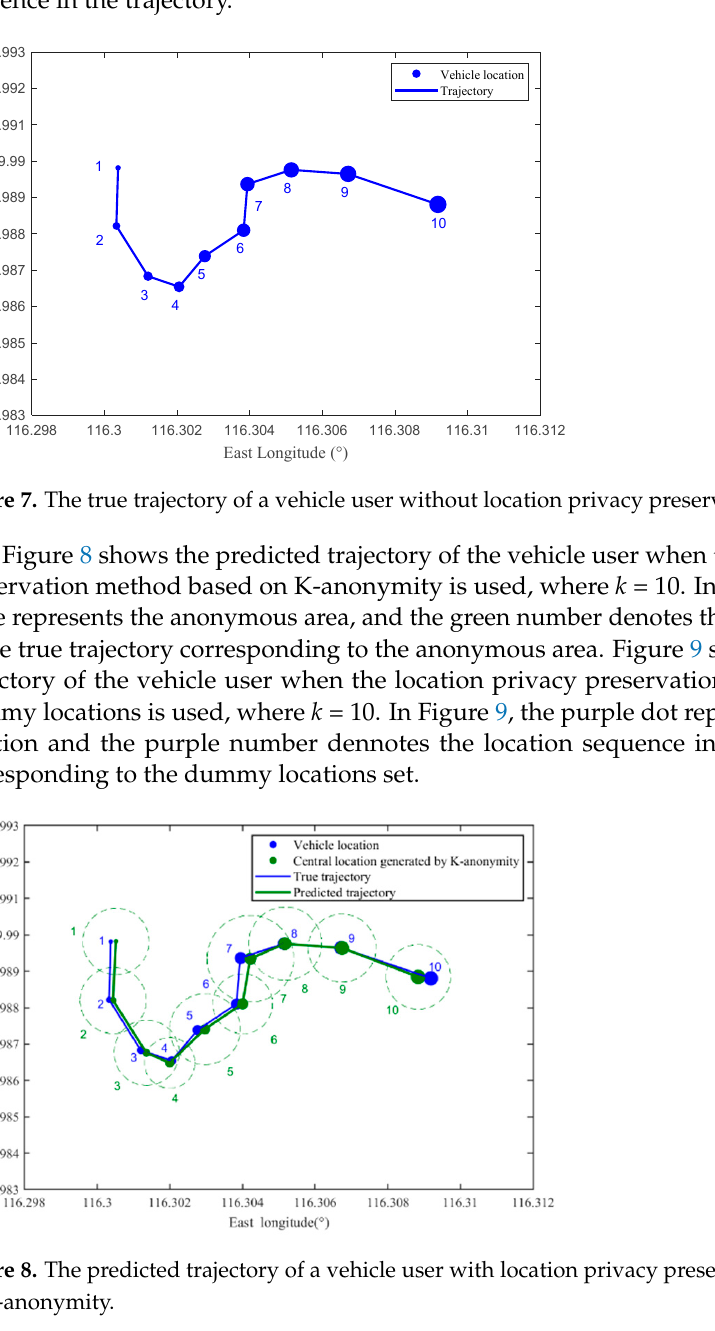
Figure 8. The predicted trajectory of a vehicle user with location privacy preservation method based on K-anonymity.